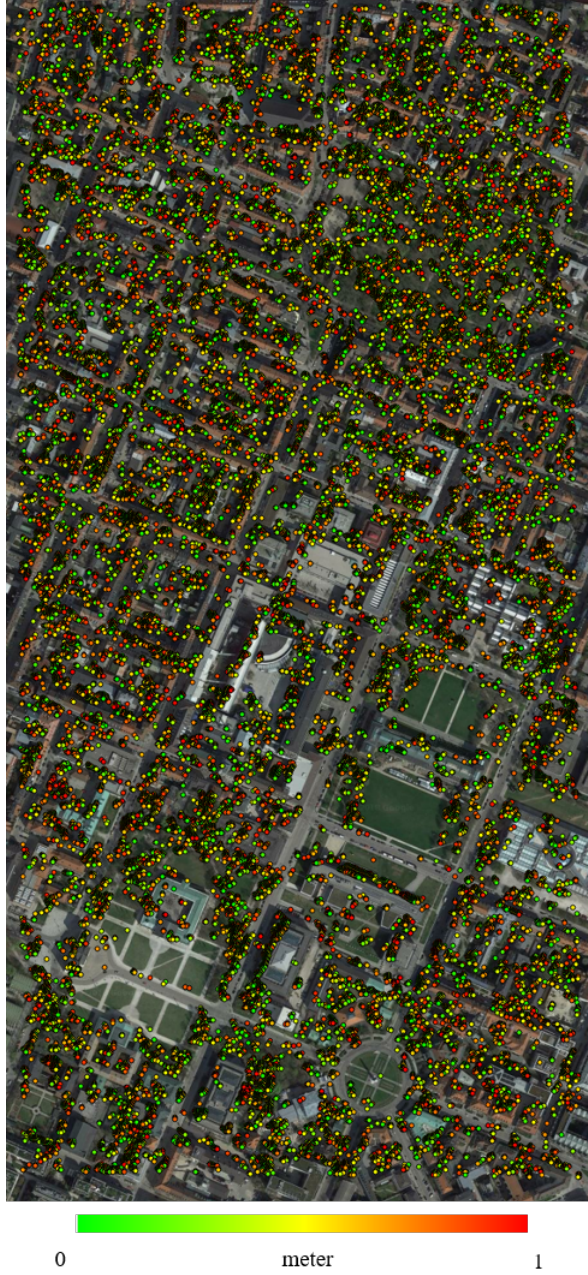
Figure 4. The position of points with accuracy lower than one pixel (1m) generated by SGM and MI cost function over Munich city with respect to a LiDAR reference point cloud. The SGM output is a sparse point cloud with an average density of about 2 points per 10 square meters and an accuracy of better than sub pixel for 30% of the points and finer than 3m for 70% of the points.